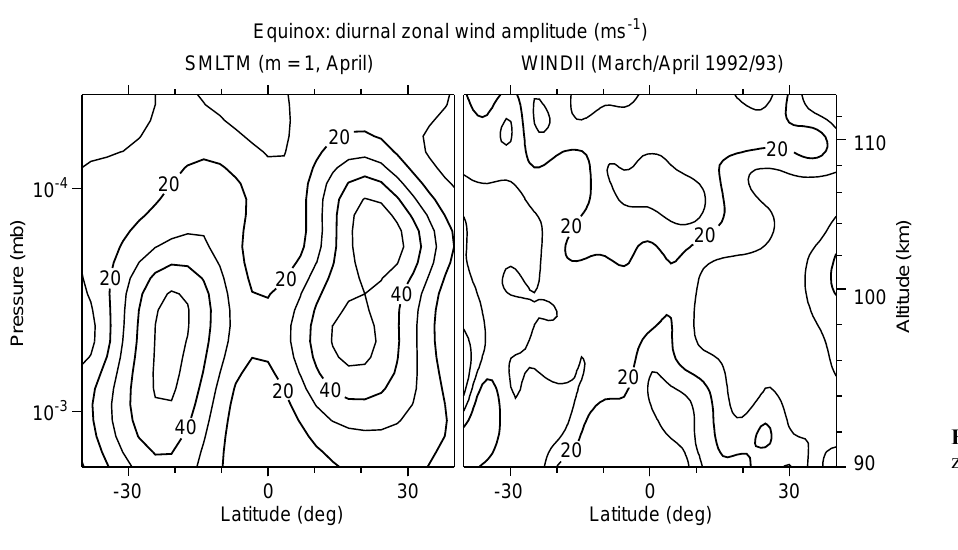
Fig. 2. Same as in Fig. 1 but for the zonal-wind component